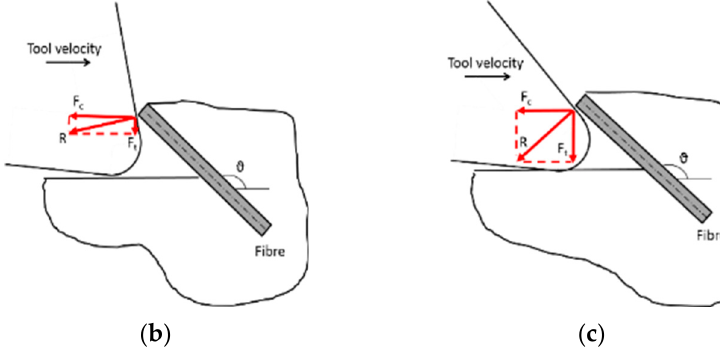
Figure 28. The thrust force component’s influence is schematically illustrated for ( a ) negative rake angle, ( b ) low positive rake angle, and ( c ) large positive rake angle.